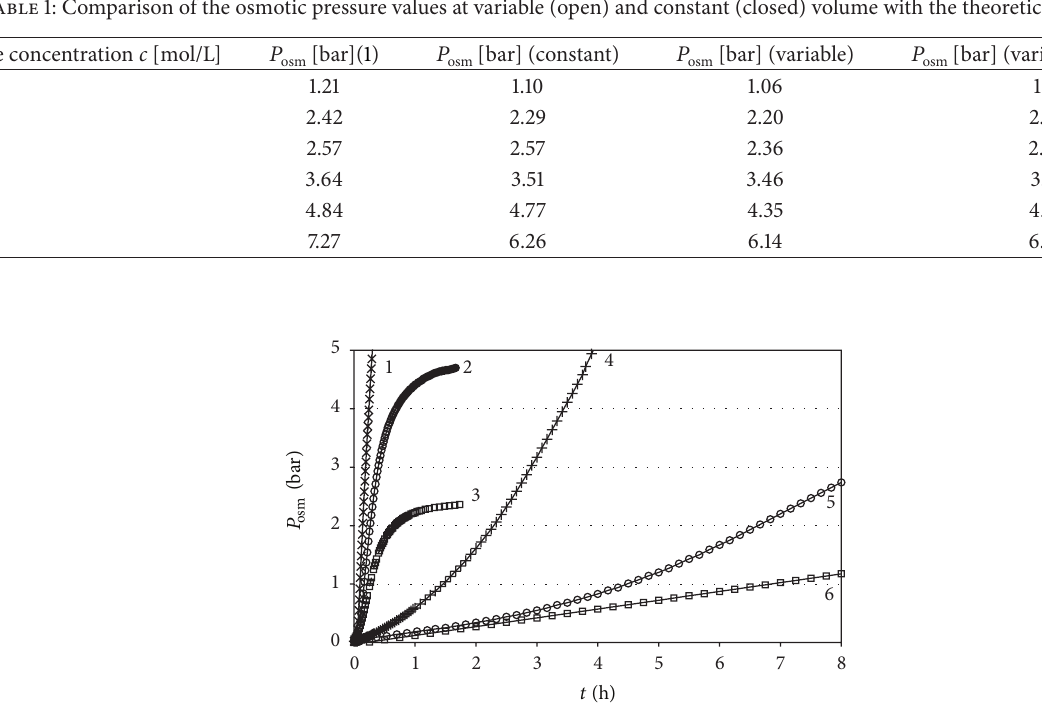
Figure 4: Osmotic pressure 𝑃 versus time 𝑡 dependence for three different initial sucrose concentrations at the two regimes: (1) 0.5M osm (constant volume); (2) 0.2 M (constant volume); (3) 0.1 M (constant volume); (4) 0.5M (variable volume); (5) 0.2M (variable volume); (6) 0.1M (variable volume).